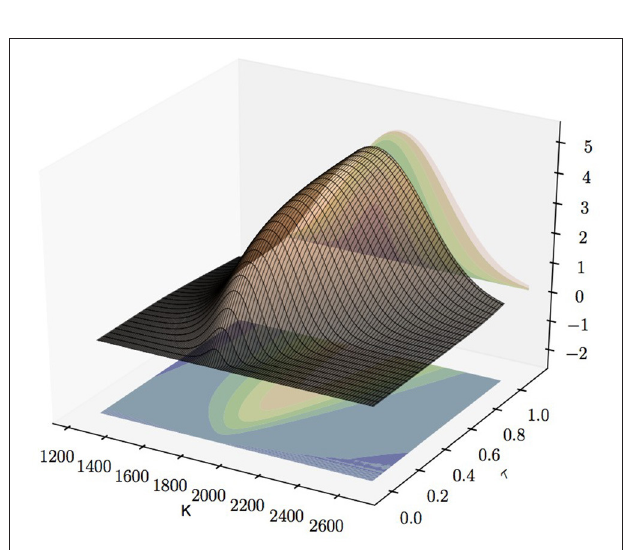
FIGURE 3 | The derivative of Heston’s call price w.r.t. the leverage parameter ρ .